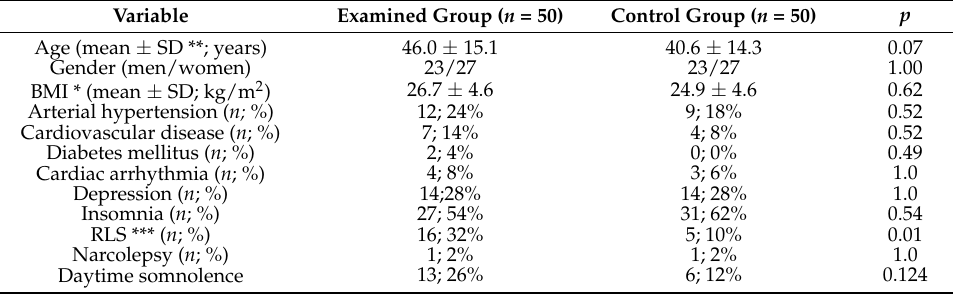
Table 1. Demographic and clinical data of the